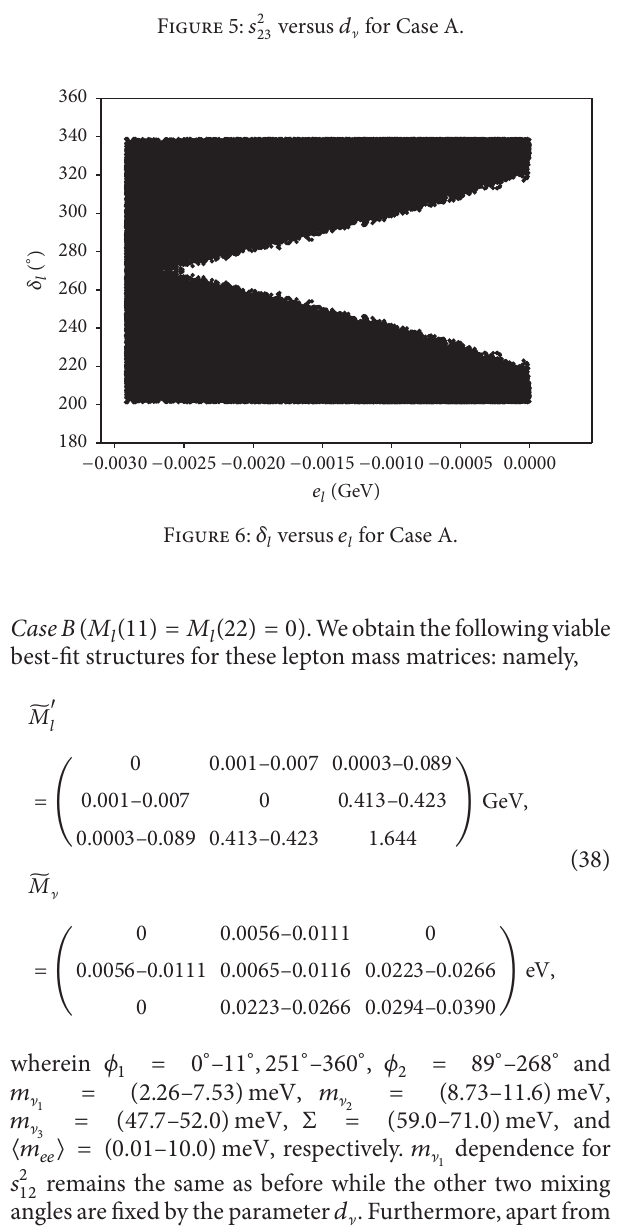
Figure 5: 𝑠 2 23 versus 𝑑 ] for Case A.